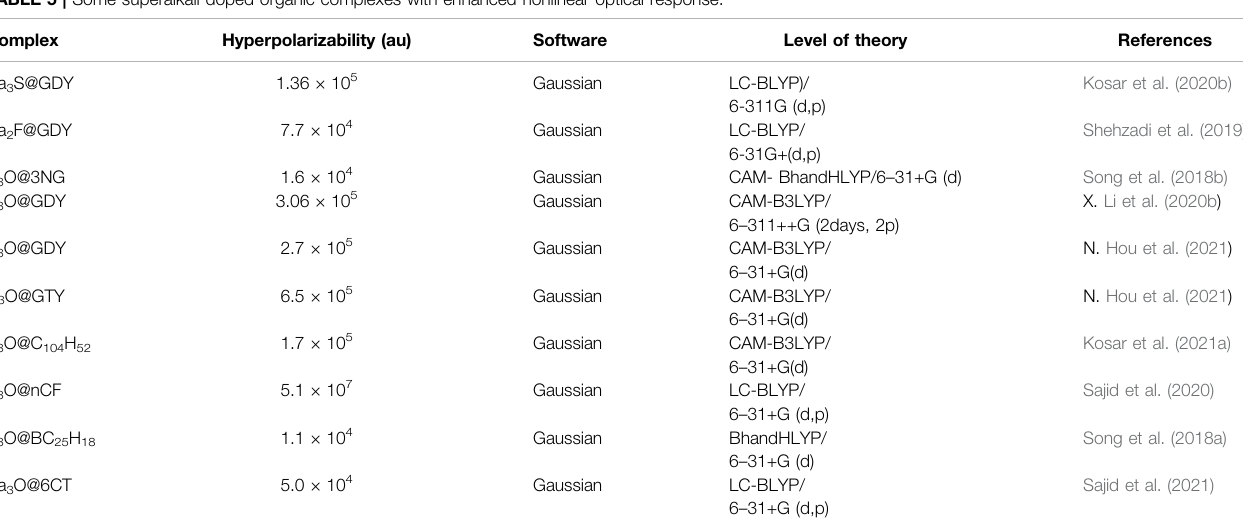
TABLE 5 | Some superalkali doped organic complexes with enhanced nonlinear optical response. Complex Hyperpolarizability (au) Software Level of